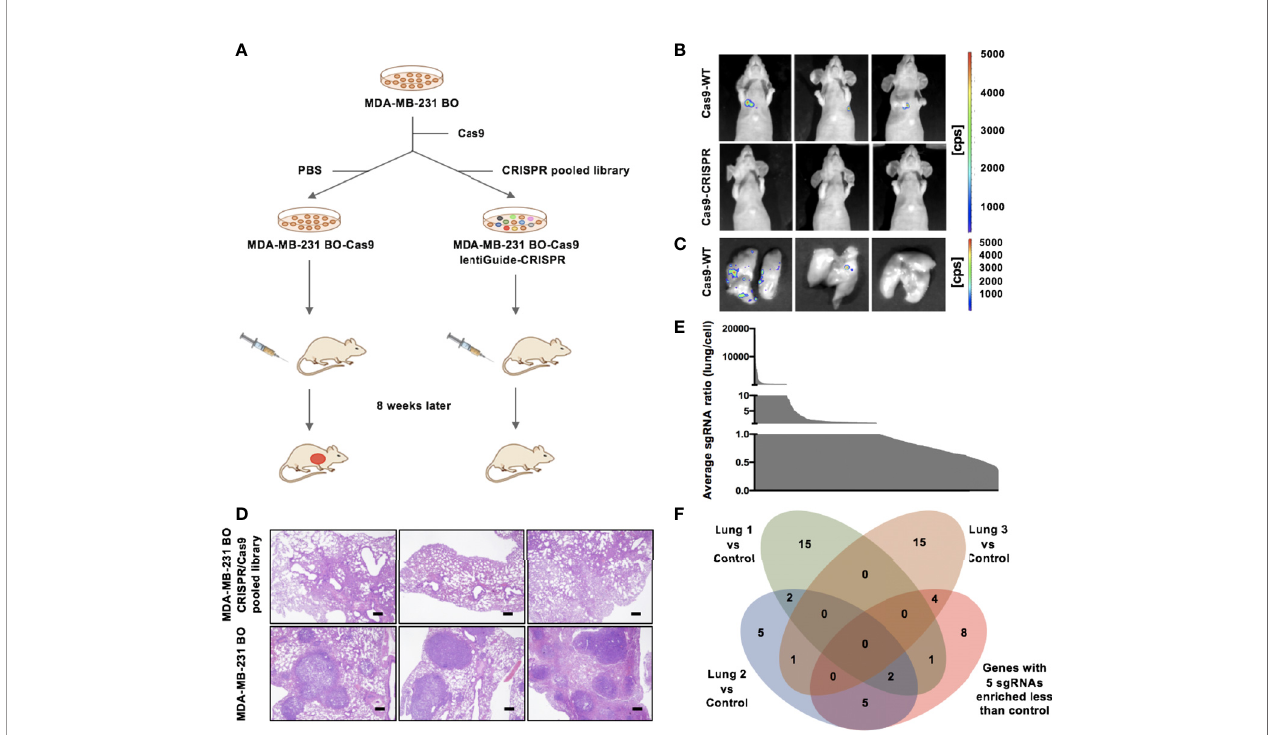
FIGURE 1 | CRISPR/Cas9 screening identi fi es CCDC102B as a metastasis promoter. (A) Outline of the CRISPR/Cas9 screening strategy. (B) BLI of three representative mice in each group 8 weeks after injection with transduced cells. (n=6 of each group) (C) BLI of three representative lungs in control group mice with metastasis. (n=6 of each group) (D) Representative images of H&E staining of lung metastasis in each group 8 weeks after injection with transduced cells. Scale bars: 500 m m. (n=6 of each group) (E) Average ratio of all individual sgRNAs in lungs versus cell pool. (F) Venn diagram of candidate breast cancer metastasis promoter